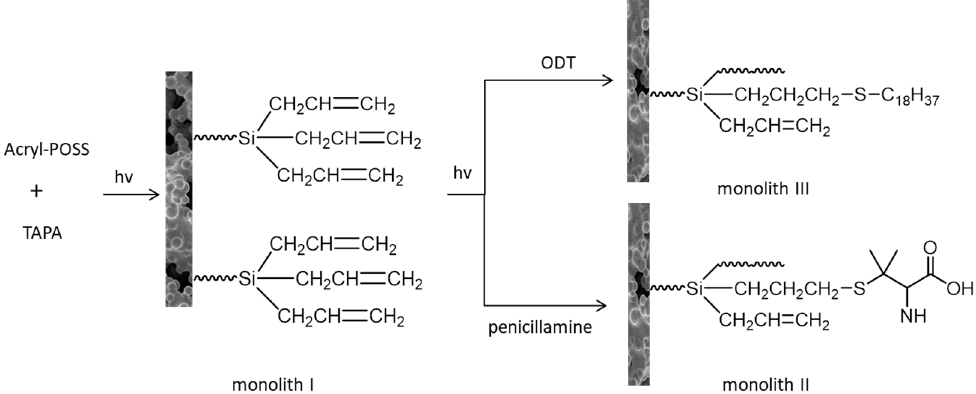
Figure 10. Preparation of monolithic column by two-step photo-initiation reaction.